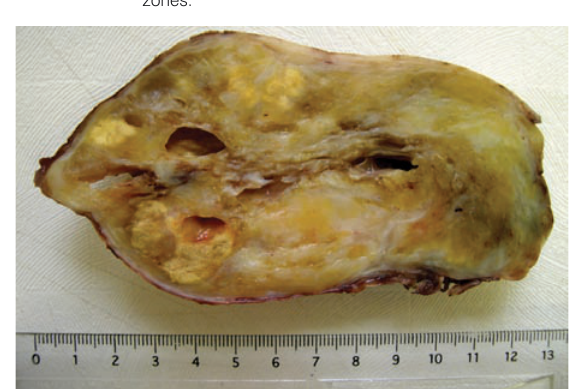
Figure 3. Dissection of the tumour shows a gray solid mass with degenerative areas, cysts and yellowish and brown color zones.